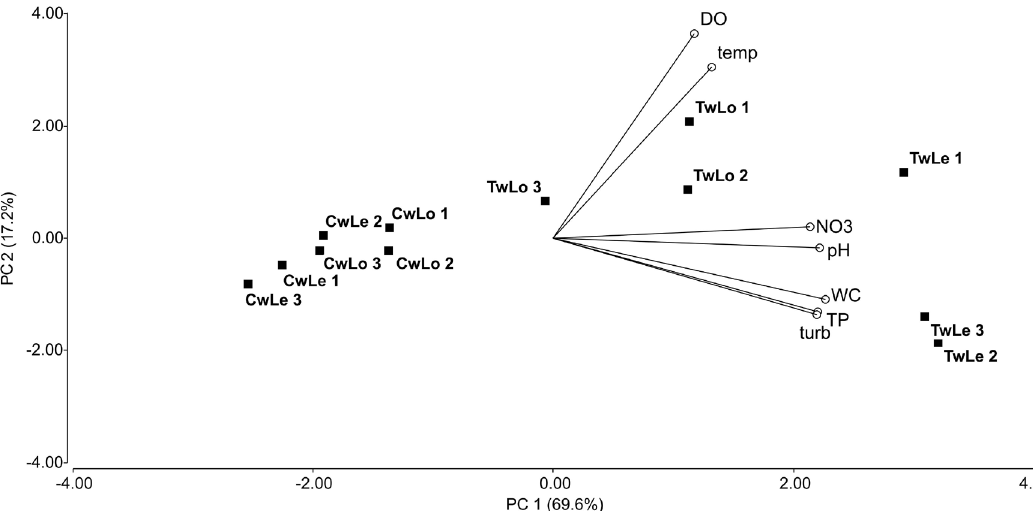
Figure 2. Biplot of the first two PCA axes based on environmental data of the Sauce Grande River (CwLe = clear water lentic conditions; CwLo = clear water lotic conditions; TwLe = turbid water lentic conditions; TwLo = turbid water lotic conditions; DO = dissolved oxygen; temp = temperature; NO3 = nitrate; WC = water conductivity; TP = total phosphorous; turb = turbidity; CP1= First Principal Component; CP2 = Second Principal